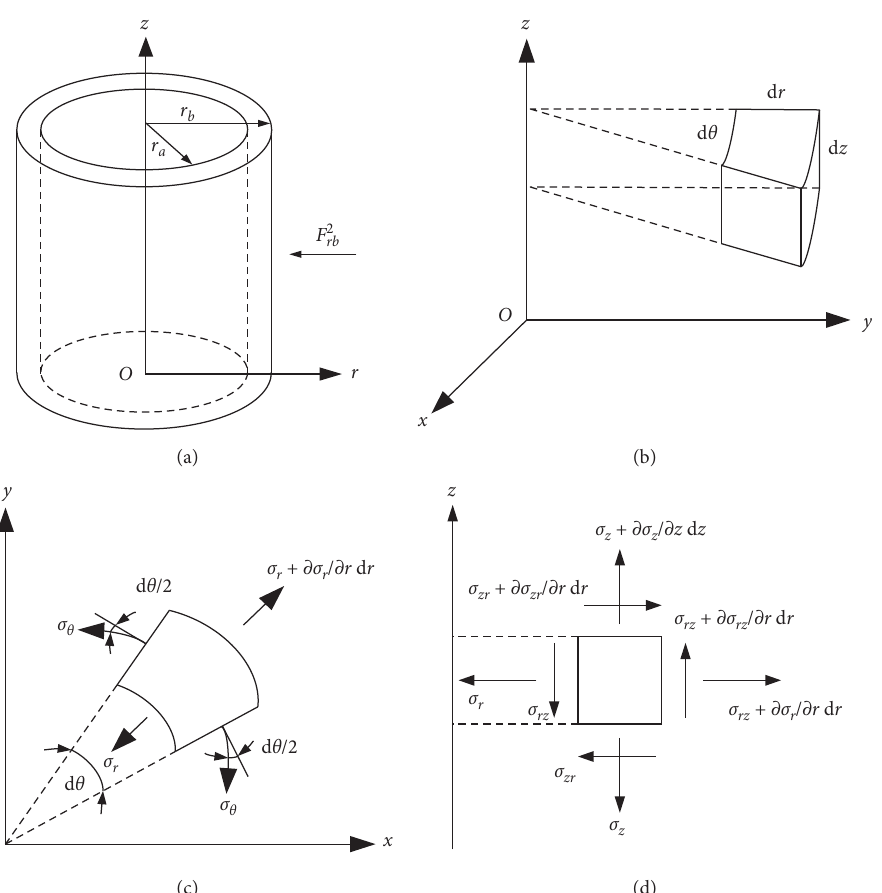
Figure 3: Mechanical model of the piezoelectric ceramic tube: (a) overall stress of piezoelectric ceramic tube, (b) infinitesimal element, (c) x − y plane force, and (d) r − z plane